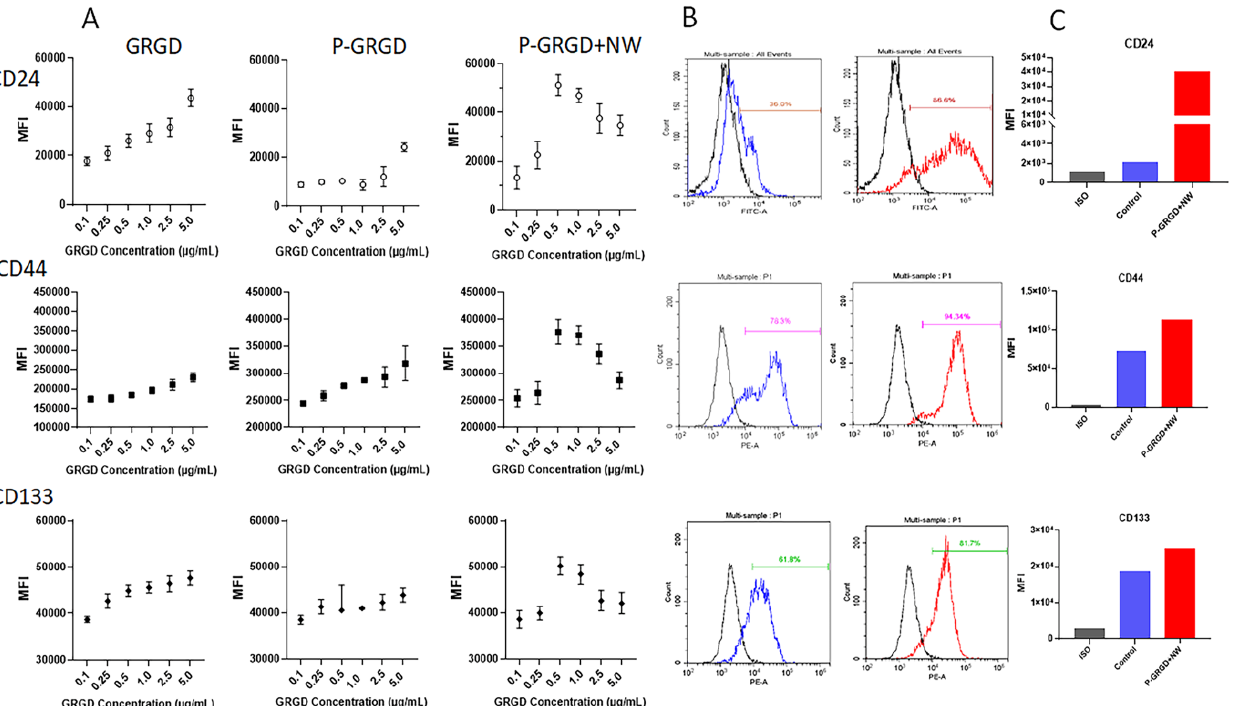
Figure 3. Influence of P-GRGD+NW treatment on the expression of surface stem markers in colon cancer cells. ( A ) flow cytometry analysis of dose-dependent expression for CSC biomarkers CD24, CD44, and CD133 after treatment with GRGD, P-GRGD, and P-GRGD+NW. ( B ) flow cytometry analysis of colon CSC surface marker expressions for CD24, CD44, and CD133 after 0.5 µ g/mL P-GRGD plus 5 µ g/mL NW treatment. ( C ) mean fluorescent intensity (MFI) of ( B